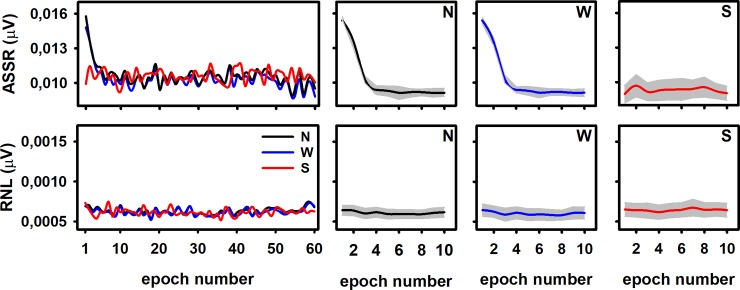
Evolution of the “instantaneous”, not accumulative ASSR amplitude (upper panels) during the stimulation period.The behavior of RNL (inferior panels) are also represented. Both the ASSR and the RNL are plotted as a function of the epoch number (index of the columns in the data matrices). Traces corresponding to a typical individual are displayed in the left panels. Means and standard deviations (8 individuals) are plotted in the rest of the panels for original (N), weighted (W) and sorted (S) datasets.